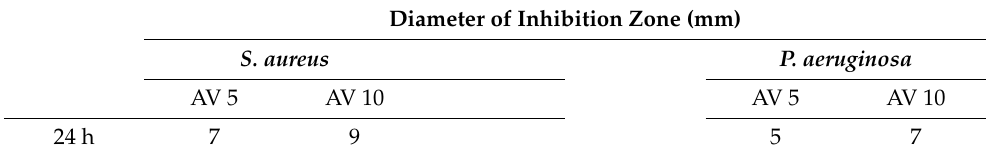
Table 2. The diameter of the zone of inhibition of S. aureus and P. aeruginosa strains treated with the Aloe vera based